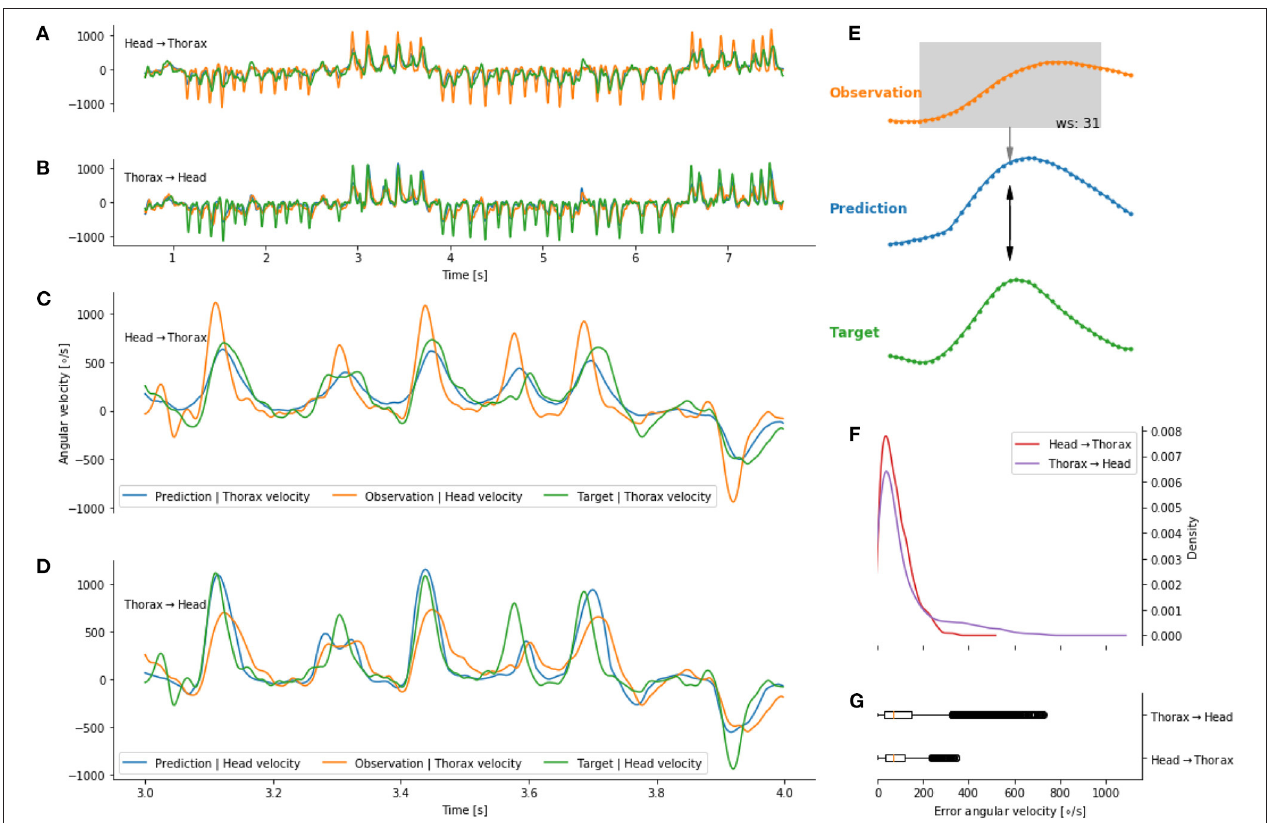
FIGURE 6 | Predicting head and thorax angular velocity (without temporal shift) on a given flight not seen during training of the artificial neural network. (A) Prediction, in blue, of the thorax angular velocity from head angular velocity (orange). (B) Prediction, in blue, of the head angular velocity from thorax angular velocity (orange). (C,D) Zoom on (A,B) , respectively. The prediction (blue line) follow the target (green line). (E) Schematic of a prediction at a given time point. (F,G) distribution of error between predictions and